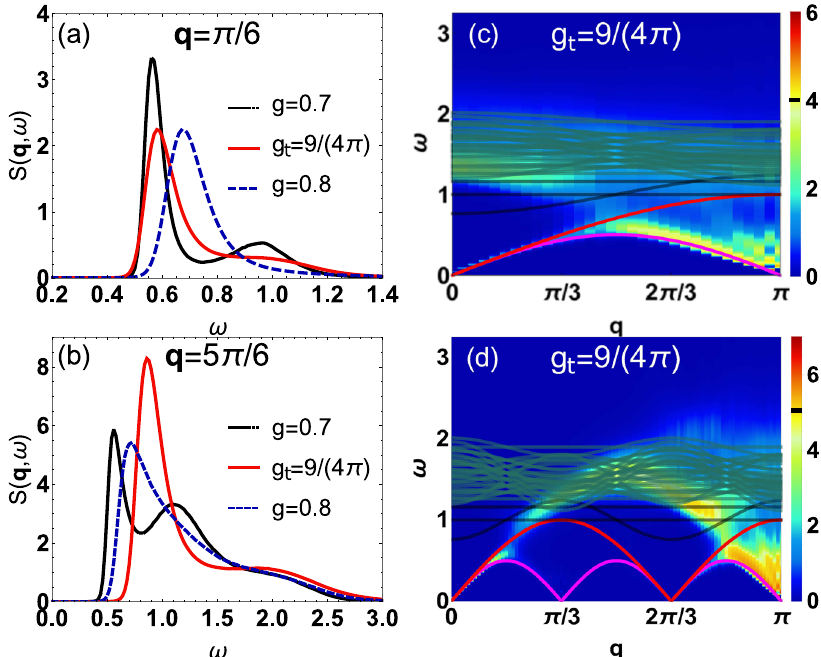
Fig. 6 QMC-SAC results and perturbative energy levels near the threshold value of g t . Sð q ; ω Þ from QMC-SAC calculation at the special q points a q = π /6 and b q = 5 π /6 for g = 0.7, 9/(4 π ), 0.8, in the region where all the different excitations merge together and their individual identities as spinons, doublons, and quartons are lost. c , d Show S red ð q ; ω Þ and Sð q ; ω Þ for g t = 9/(4 π ) in the reduced and full BZs, respectively. The upper boundary of the two-spinon continuum (red solid line) and the dispersion relation Eq. 7 corresponding to the intermediate-energy branch (black solid line) cross over at q = π . The boundaries between the linear and logarithmic color mappings are ( c ) U 0 = 4 and (d) U 0 = 5, respectively, as indicated on the color